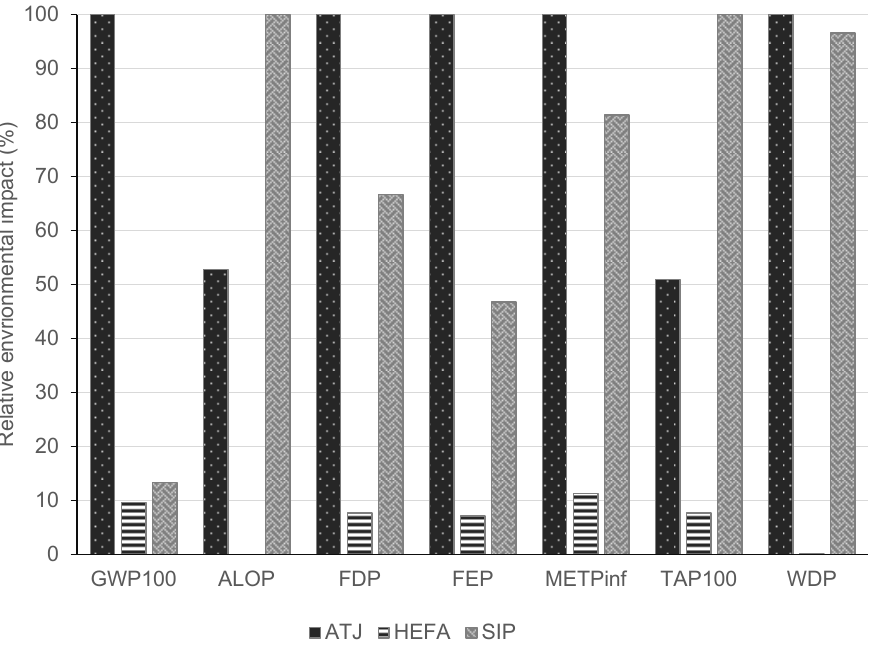
Figure 2. Relative environmental impacts of SAF production.